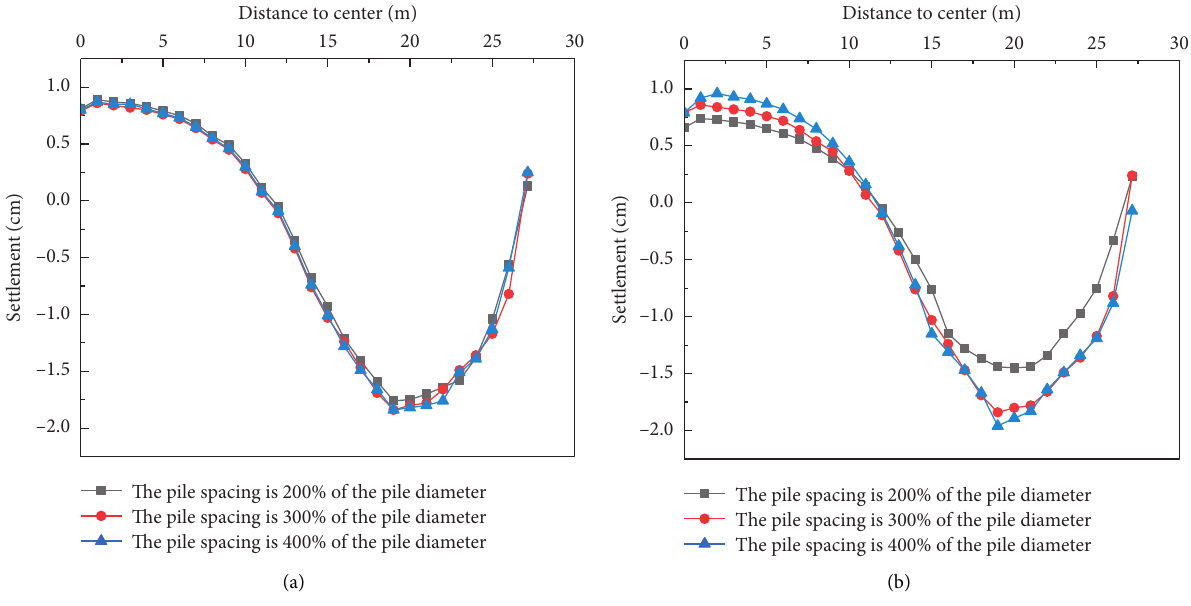
Figure 8: Settlement diagram of the foundation surface at completion under different piles spacings. (a) Varying the pile spacing under the existing road slope. (b) Varying the pile spacing under the existing subgrade and new